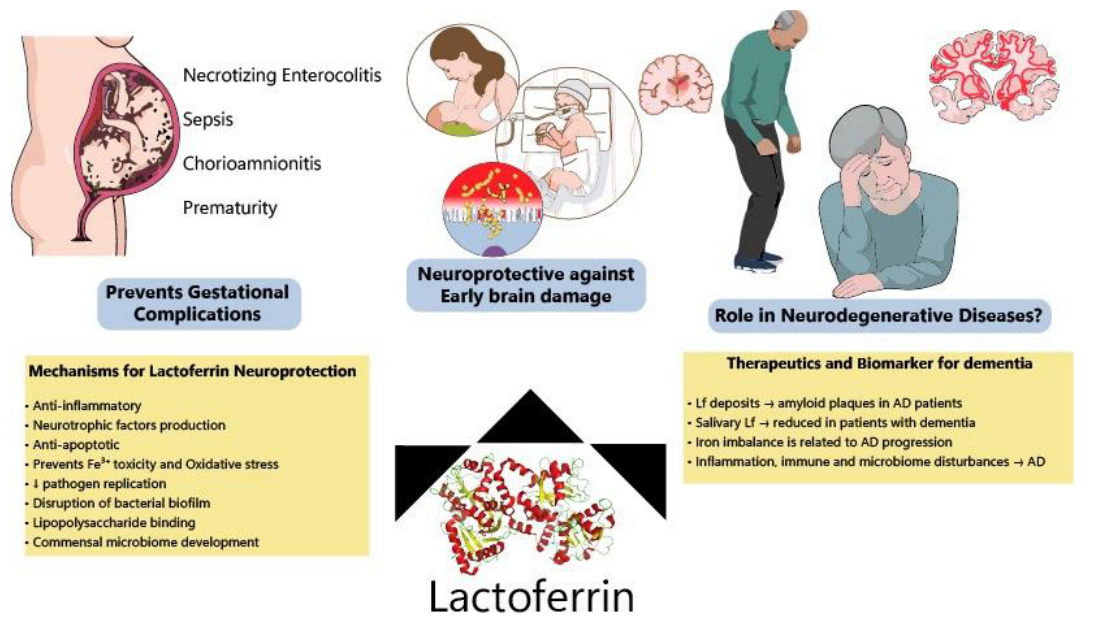
Figure 3. Protective effects of lactoferrin through the lifespan. Lf has been shown to prevent disturbances during pregnancy, decreasing the incidence of NEC, sepsis and prematurity among other complications. Allied to this, clinical and preclinical data have indicated that Lf modulates several pathways (ion scavenger, anti-inflammatory, anti-apoptotic and improving microbiome) protecting the developing brain. Lf has also been considered a potential biomarker of neurodegeneration and its mechanisms of action make it a good candidate to be tested for the prevention of neurodegenerative diseases.